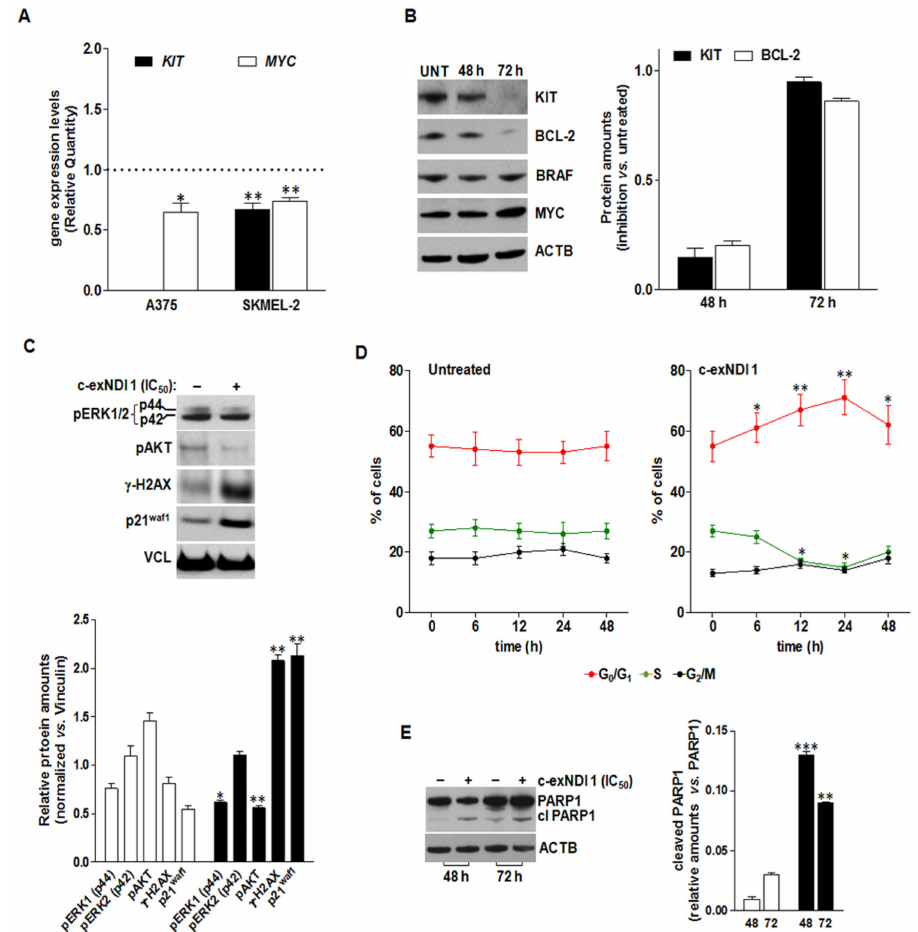
Figure 3. ( A ) Analysis of KIT and MYC mRNA expression levels in A375 and SKMEL-2 cells upon 48 h of exposure to 1 (IC 50 ). Data are reported as Relative Quantity (mean RQ values ± s.d.) in treated vs. untreated cells, according to the 2 − ∆∆ Ct method. Dotted line: calibrator sample. ( B ) Representative Western immunoblotting showing the e ff ects of 48 and 72 h of exposure of A375 cells to 1 (IC 50 ) on the amounts of the indicated proteins. Cropped images of selected proteins are shown. Beta-actin (ACTB) was used to ensure equal protein loading. The graph on the right shows the extent of KIT (black bars) and BCL2 (white bars) protein inhibition in A375 cells exposed to 1 (IC 50 ) for 48 and 72 h. Data are reported as the inhibition of protein expression in treated vs. untreated cells, and represent the mean values ± s.d. from at least three independent experiments. ( C ) Representative Western immunoblotting showing the amounts of the indicated proteins in untreated ( − ) A375 cells and upon 72 h of exposure ( + ) to 1 (IC 50 ). Vinculin (VCL) was used to ensure equal protein loading. Cropped images of selected proteins are shown. The graph on the bottom reports the quantification of protein levels in untreated (white bars) and 1 -treated (black bars) A375 cells. Data are reported as relative protein amounts following the normalization of densitometric signals toward Vinculin, and represent the mean values ± s.d. ( D ) Time-dependent assessment of the cell cycle in untreated and 1 -treated A375 cells. Data are reported as the percentages of cells in G0 / G1 (red), S (green), and G2 / M (black) phases of the cell cycle, and represent the mean values ± s.d. from at least three independent experiments. ( E ) Representative Western immunoblotting showing the amounts of full length and cleaved PARP1 in untreated ( − ) A375 cells and upon 48 and 72 h of exposure ( + ) to 1 (IC 50 ). Beta-actin (ACTB) was used to ensure equal protein loading. Cropped images of selected proteins are shown. The graph on the right reports the amounts of cleaved PARP1 in untreated (white bars) and 1 -treated (black bars) cells. Data are reported as relative protein amounts vs. full length PARP1, and represent the mean values ± s.d. * p < 0.05; ** p < 0.01; *** p < 0.001 (Student’s t